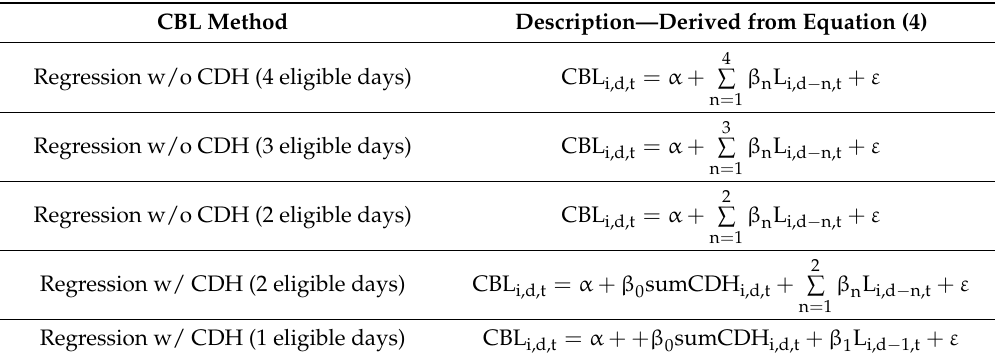
Table 4. Regression models.